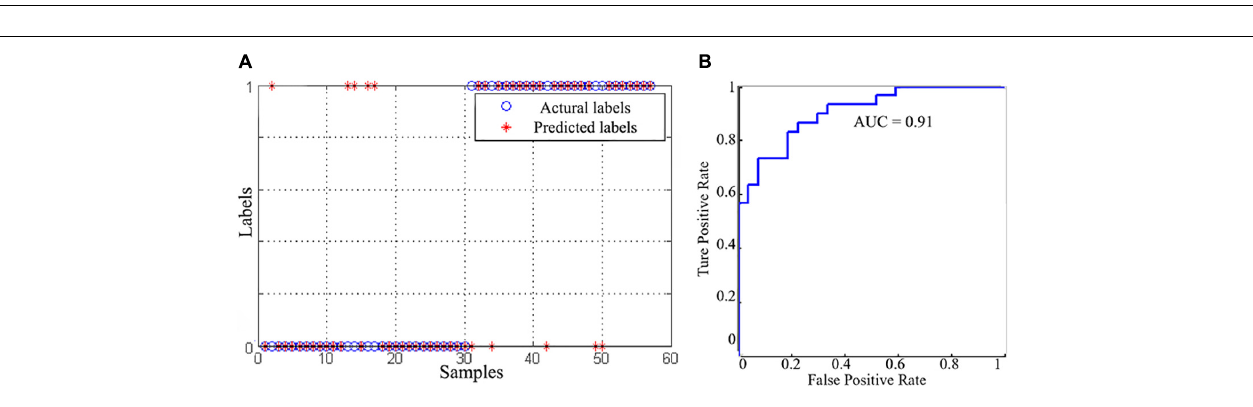
FIGURE 4 | The classification performance of SVC model. (A) The classification results between the IA and HC groups. (B) The receiver operating characteristic curve of the SVC